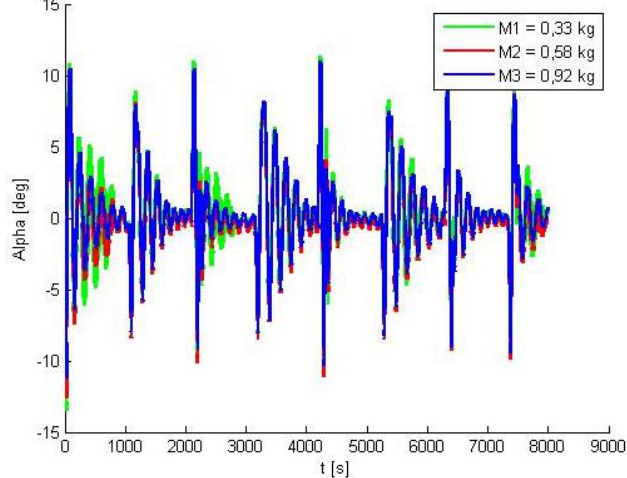
Fig. 14. Anti-swing 5DOF fuzzy logic regulator Z -axis position simulation results.